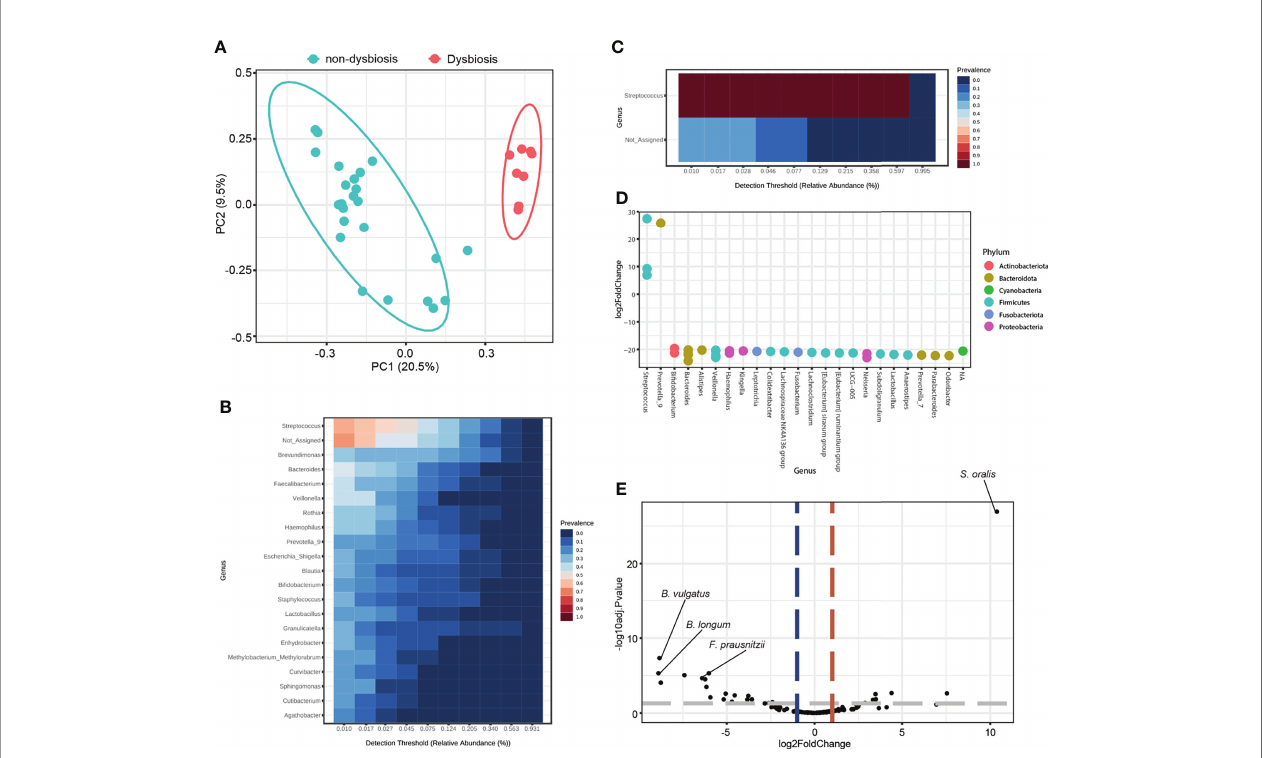
FIGURE 6 | Differential analysis based on microbiome dysbiosis. (A) Principal coordinate analysis of saliva samples based on the Bray-Curtis distance method ( n = 32). Red dots indicate samples in a distinct cluster, which was denoted as the dysbiosis group. Eclipses represent 95% con fi dence interval. (B) Core microbiome analysis of saliva from the non-dysbiosis group at the genus level. (C) Core microbiome analysis of saliva from the dysbiosis group at the genus level. (D) DESeq2-driven differential features of the microbiome at the genus level. Positive values of log2 fold change indicate increased abundance in the dysbiosis group. (E) Volcano plot showing differential ASVs derived from metagenomeSeq between the dysbiosis and non-dysbiosis groups. Gray dashed line indicates p-value cutoff ( p = 0.05). Red and blue dashed lines indicate fold change cutoff (fold change =